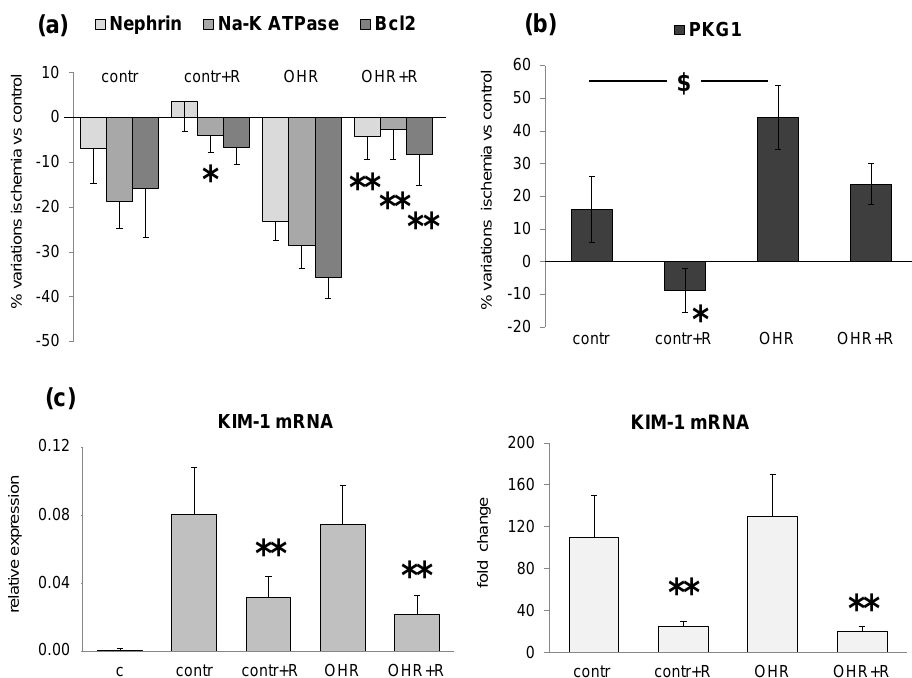
Figure 3. Effect of ouabain infusion and rostafuroxin treatment on IRI-induced alterations of renal markers. Ouabain was infused in rats at 30 µg/kg/day for eight weeks by osmotic mini-pumps (OHR rats). Controls received saline. After four weeks, a group of OHR and control rats received orally rostafuroxin at 100 µg/kg/day for four weeks, or vehicle. At the eighth week, all rats underwent ischemia and were sacrificed after five days. The expression of marker proteins was quantified in ischemic versus contra-lateral healthy kidney. Data are mean ± SEM, n = 8/13 rats per each group, see Methods. ( a , b ) Percent variation of protein expression in ischemic versus contra-lateral kidney for nephrin, α 1 Na-K ATPase, Bcl2, and PKG1; ( c ) KIM-1 mRNA as relative expression in ischemic and contra-lateral kidney ( left ) and as fold change ( right ) in ischemic versus contra-lateral kidney quantified by RT-PCR. c, contra-lateral kidney; contr, control; R, rostafuroxin. * p < 0.05; ** p < 0.01 plus versus minus rostafuroxin; $ p < 0.05 OHR versus contr.